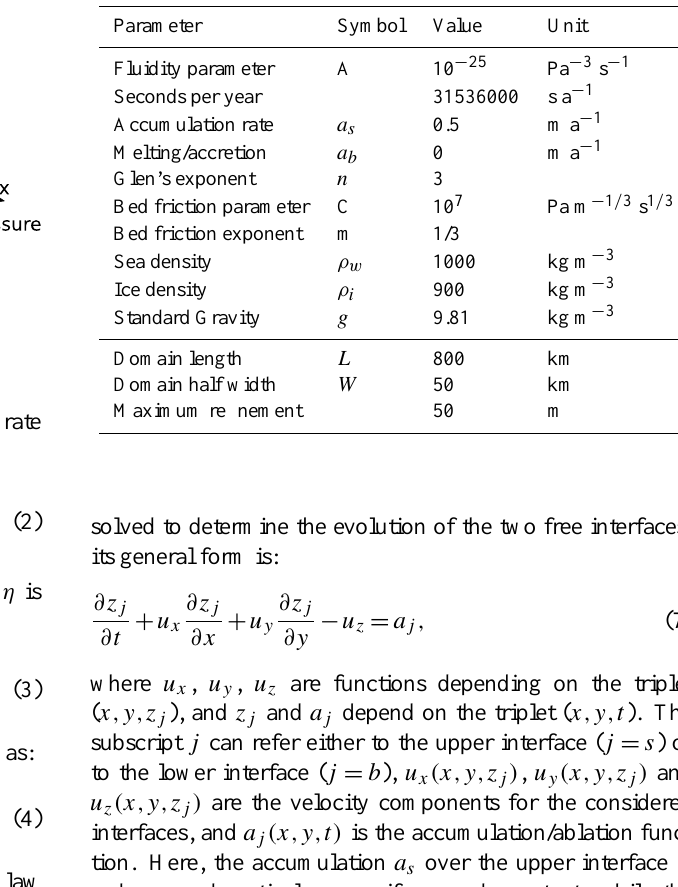
Table 1. Numerical values of the parameters adopted for the simu-